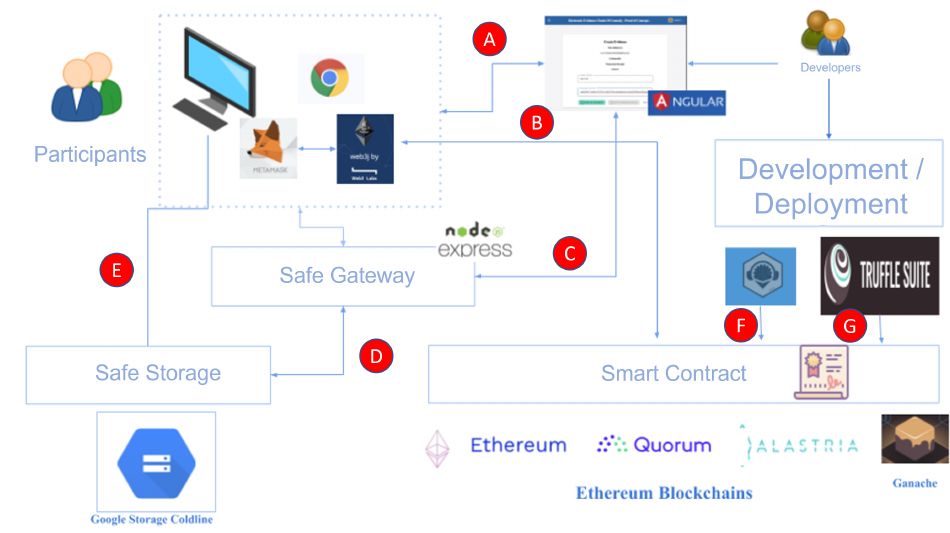
Figure 6. Architecture of the Prototype